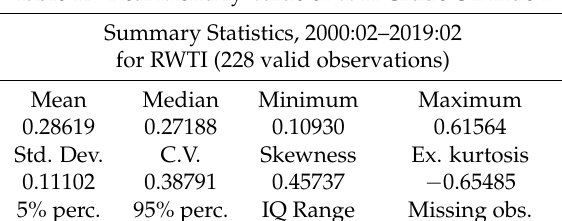
Table 1B: Real Monthly Value of WTI Crude Oil